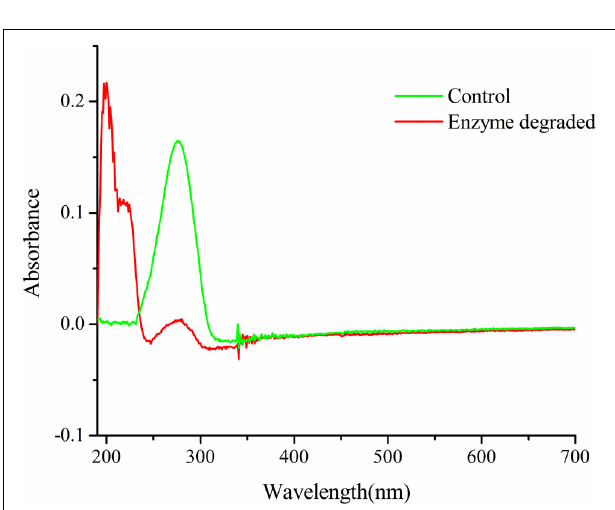
FIGURE 9 | The structure of degraded product of